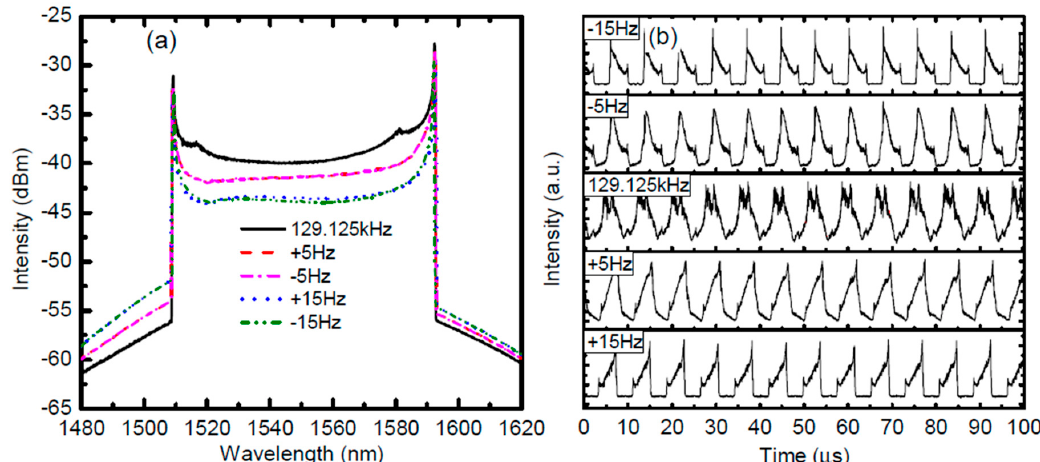
Figure 3. The ( a ) integrated spectra and ( b ) waveforms of the FDML fiber laser harmonically mode- locked in the third order. The scan frequency of FFP-TF is 129.125 kHz and relative detunes are ±5 Hz and ±15 Hz. Reprinted with permission from Ref. [92].